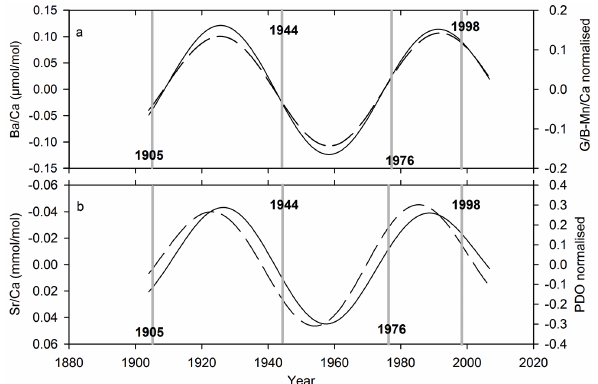
Fig. 8. A 50–70yr band pass filter (0 . 017 ± 0 . 003) applied to (a) MAS1 Ba/Ca (dashed) and MAS1 G/B-Mn/Ca (solid); and (b) MAS1 Sr/Ca data (dashed) and the Mantua PDO index (solid). The grey bars represent the transition years of different phase changes of the